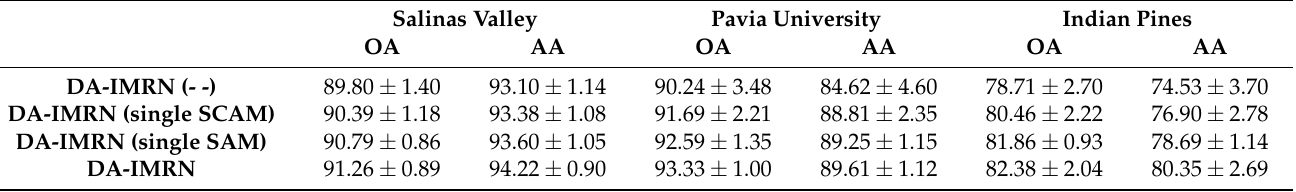
Table 6. Impact of the SCAM and SAM in terms of OA and AA (in %). DA-IMRN (- -) denotes the network without any attention module or interaction between two branches. Both the SAM attention modules and their inputs are removed in the network DA-IMRN (single SCAM). Similarly, the SCAM attention modules and their inputs are discarded in the network DA-IMRN (single